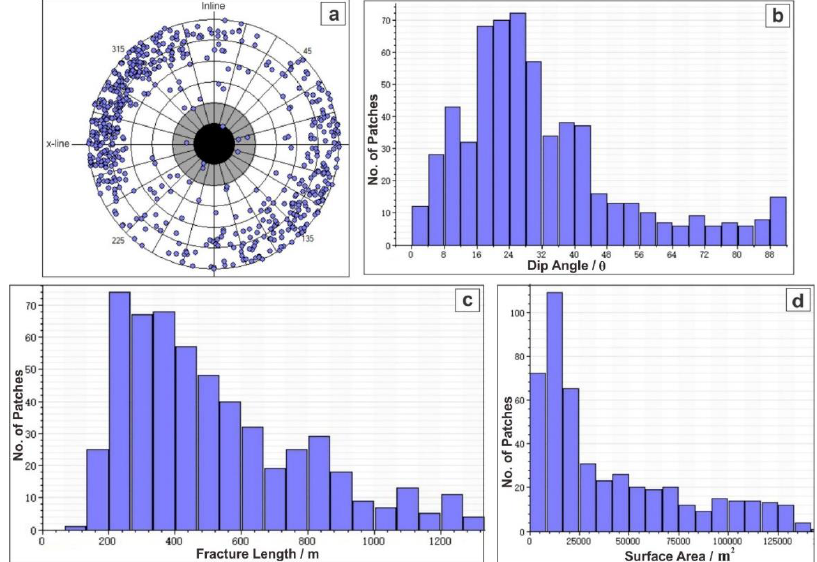
Figure 18. ( a ) Stereonet showing the distribution of azimuth of the extracted fractures from seismic volume; ( b ) histogram of fracture dip angle; ( c ) histogram of fracture length; and ( d ) histogram of the fracture surface area.